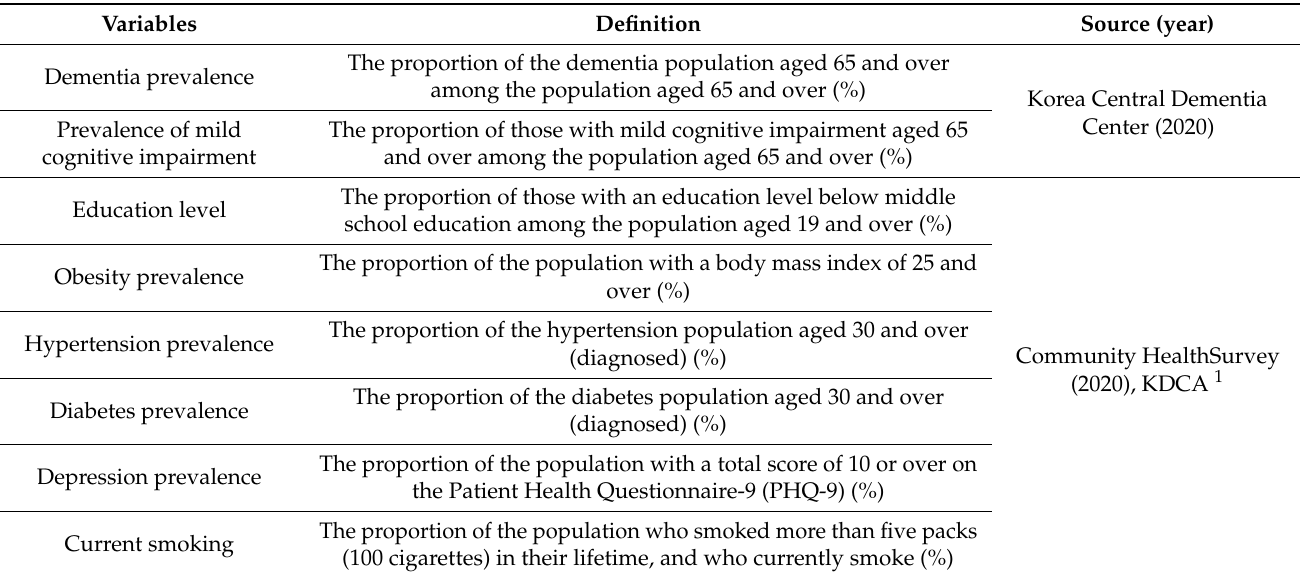
Table 1. Variable